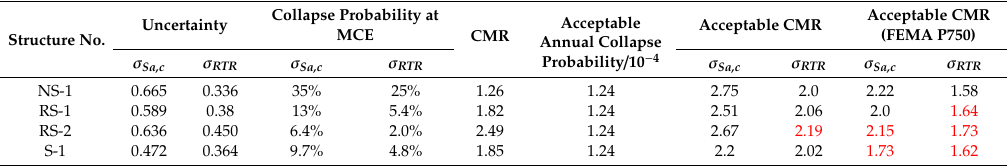
Table 3. Collapse performance